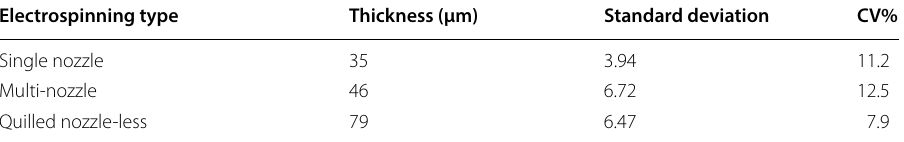
Table 3 Thickness of PAN nanofibers mats Electrospinning